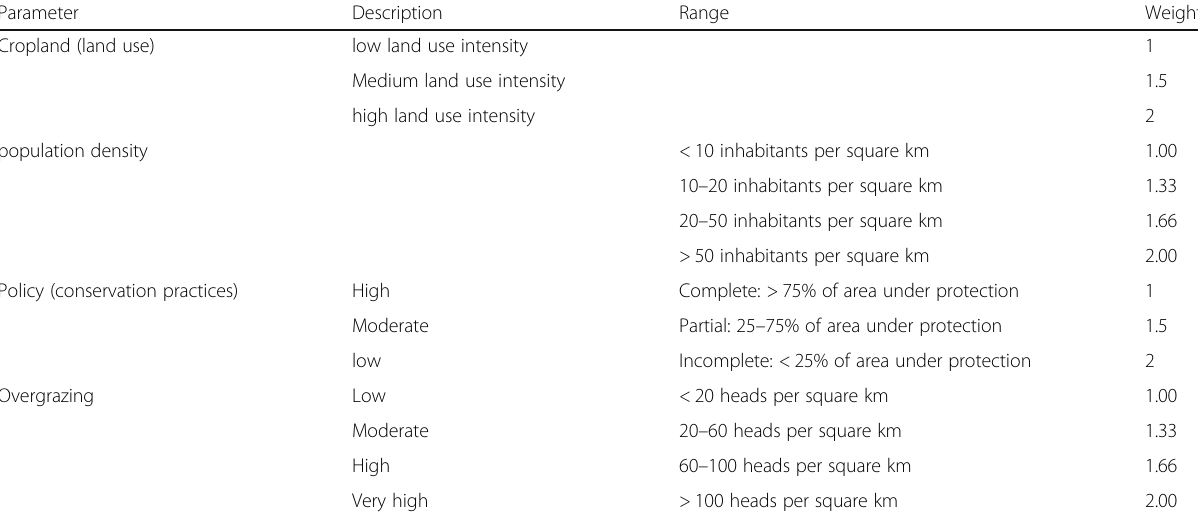
Table 8 Assigned weighing indices for various parameters used for assessment of management quality (Kosmas et al. 1999; UNESCO – United Nations Educational: Scientific and Cultural Organization 1979; Vieira et al.